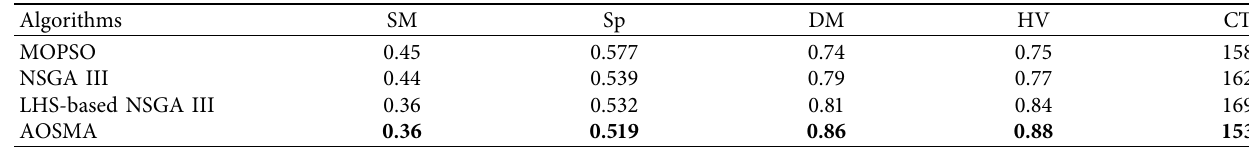
Table 9: Comparison of AOSMA with other